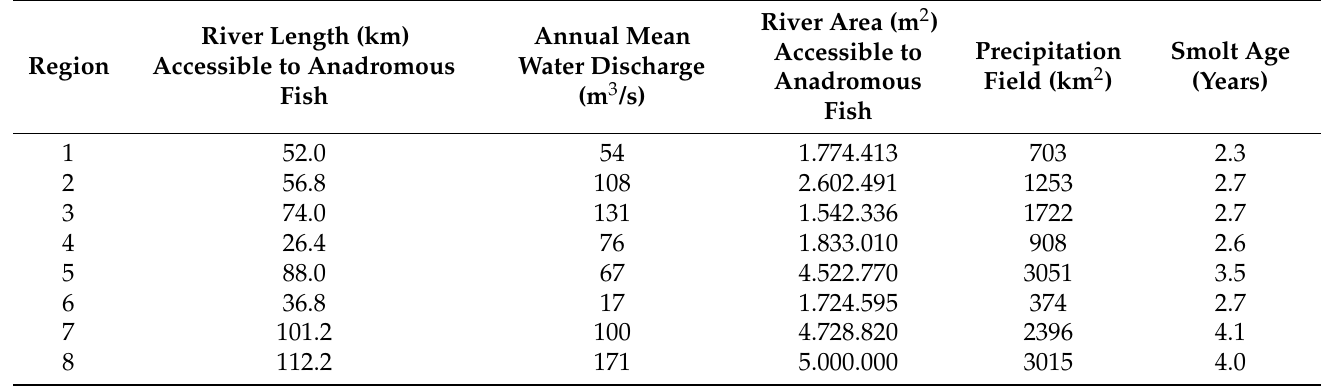
Table 2. Hydrogeographic information and average smolt age of the eight studied regions of the present